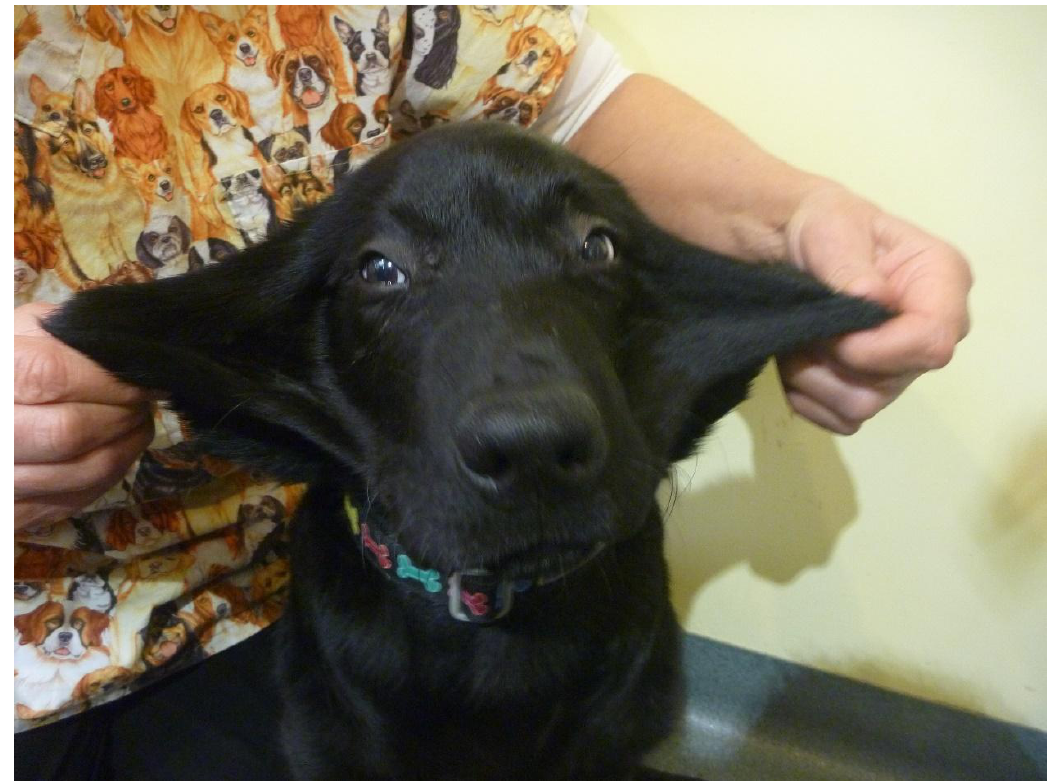
Figure 3. Case 1, Skin hyperextensibility of the face.